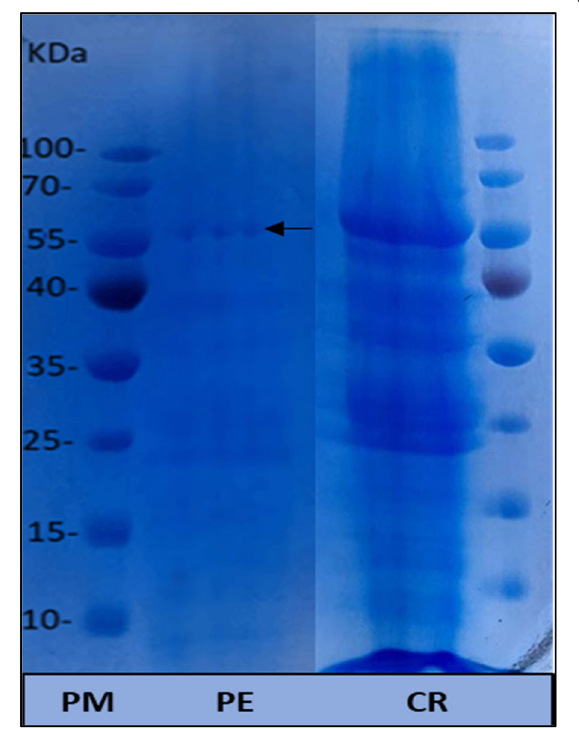
Fig. 2 Molecular weight of recombinant peroxidase by electrophoretic analysis on 7.5% SDS‑PAGE. PM, molecular weight marker proteins. PEP, purified peroxidase. CR, crude